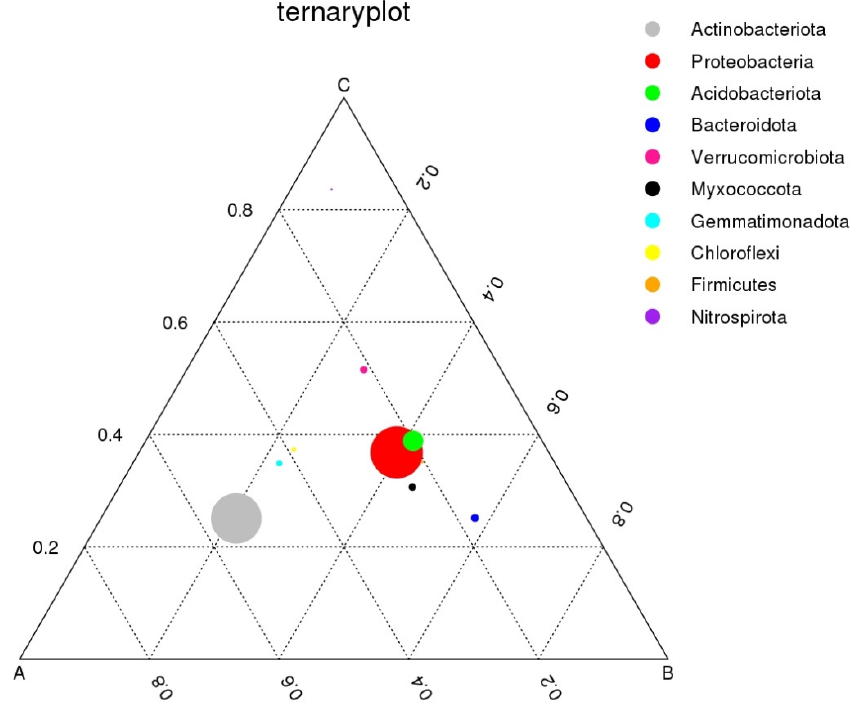
Figure 5. Ternary plot of metagenomic analyses of thermophilic and mesophilic phases of composts Harmanli (A), Yasno pole (B) and row biowastes (C). Circles represent dominant taxa, while their sizes are proportional to the relative abundance. The taxa from the circled group have a higher abundance of the same type.